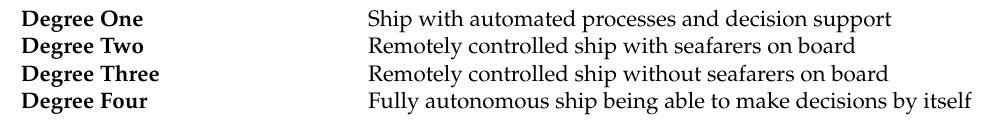
Table 1. The degrees of autonomy [4].